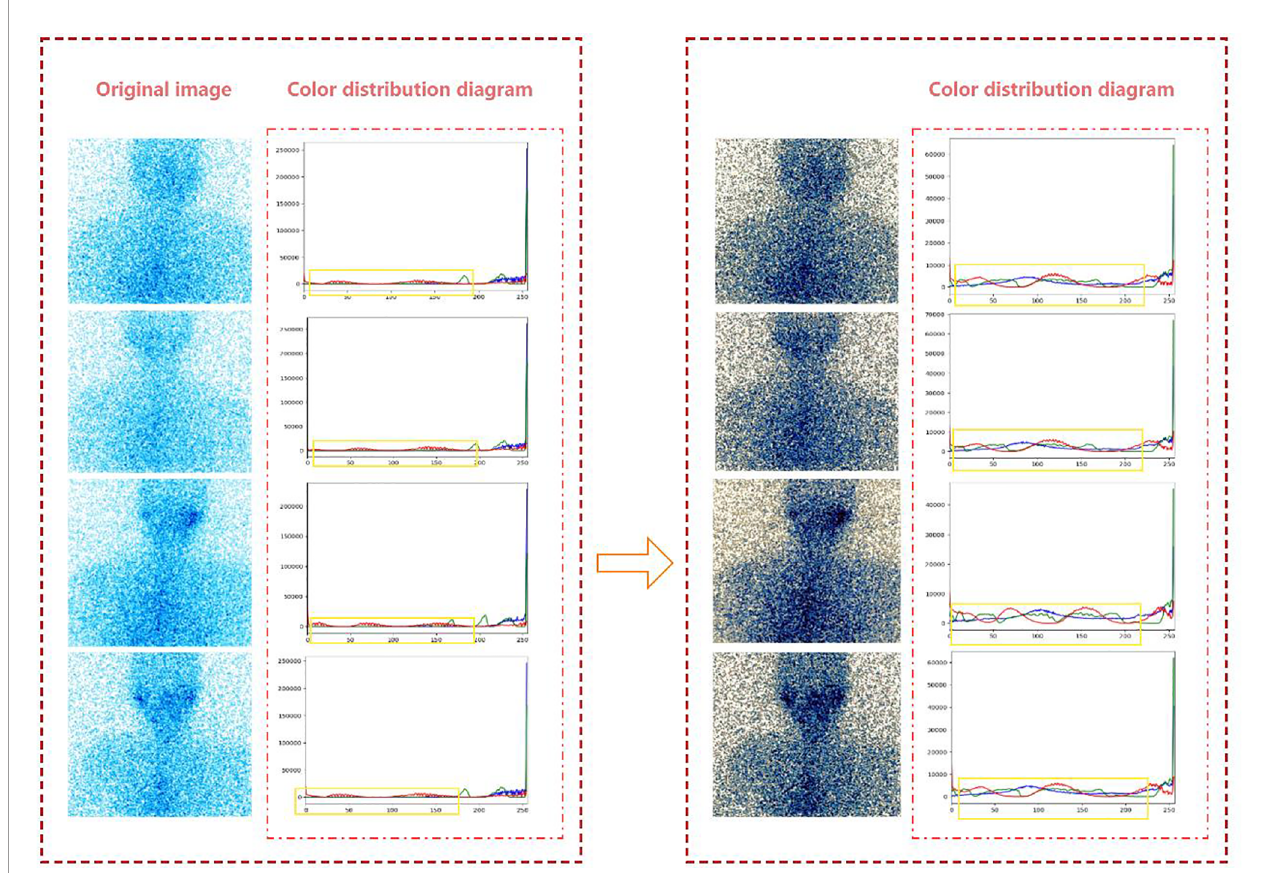
FIGURE 2 | The effect of histogram equalization on the improvement of SPECT image quality and the